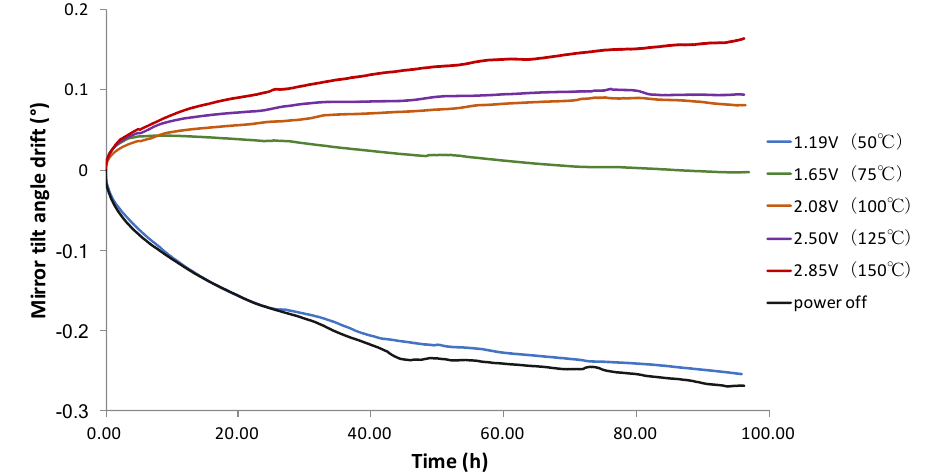
Figure 6. Mirror tilt angle drift as a function of time with various driving